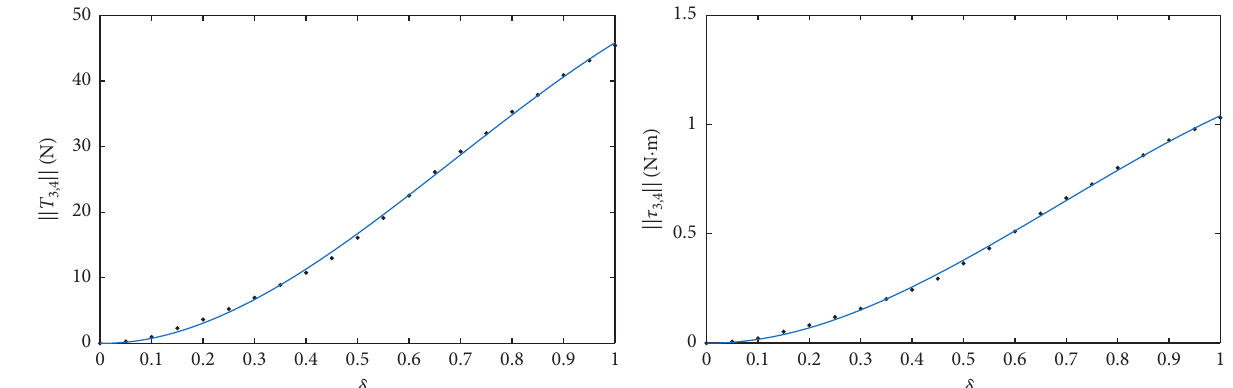
Figure 5: Measured values of the thrust and torque of the back motors versus the throttle δ